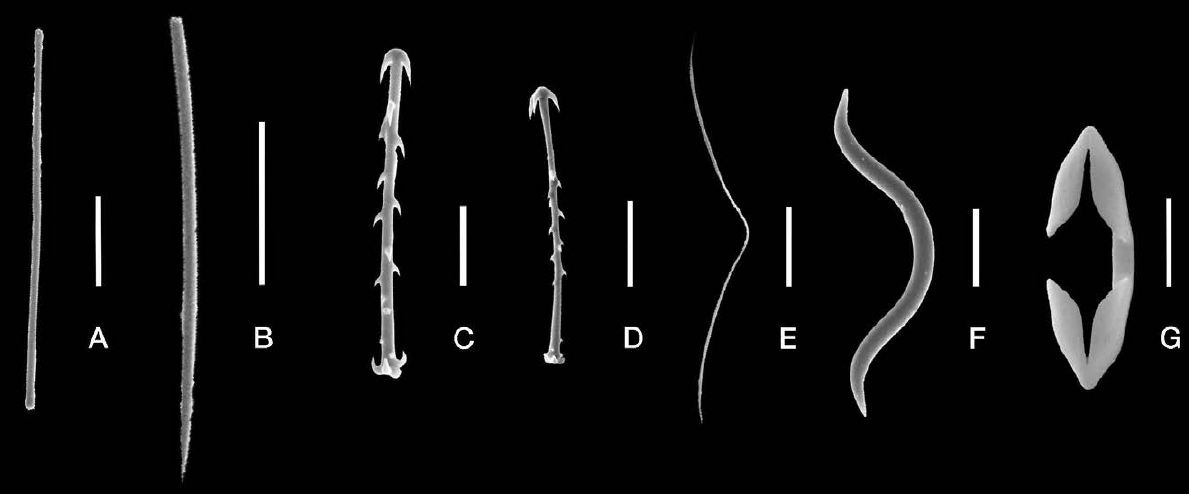
Fig . 6. – Acarnus oaxaquensis n. sp. A, Ectosomal tylote with microspined heads. B, Choanosomal style with microspined base. C, Cladoylote I microspined with four clades. D, Cladotylote II microspined with four clades. E, Toxa I. F, Toxa II. G, Palmate isochela. Scale: A, C, E,